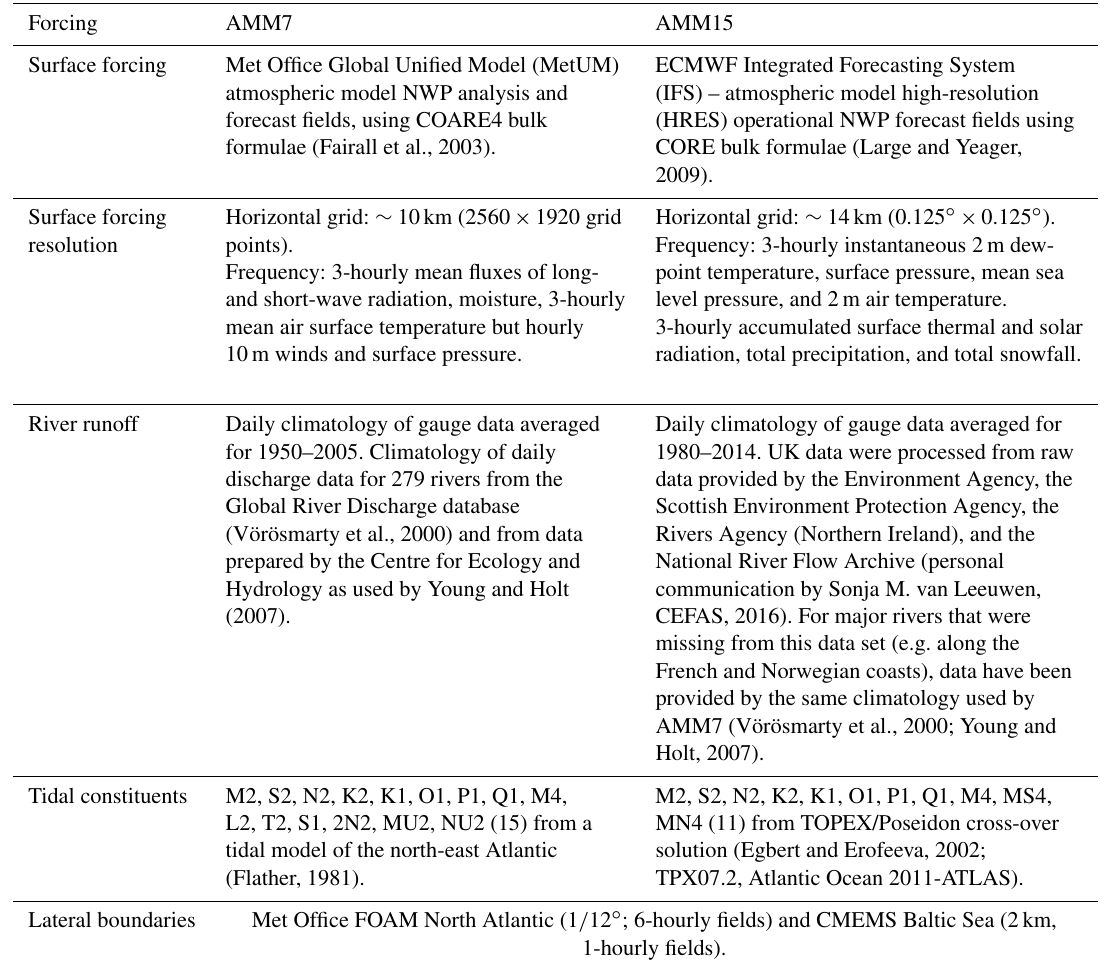
Table 2. AMM7 and AMM15 forcing